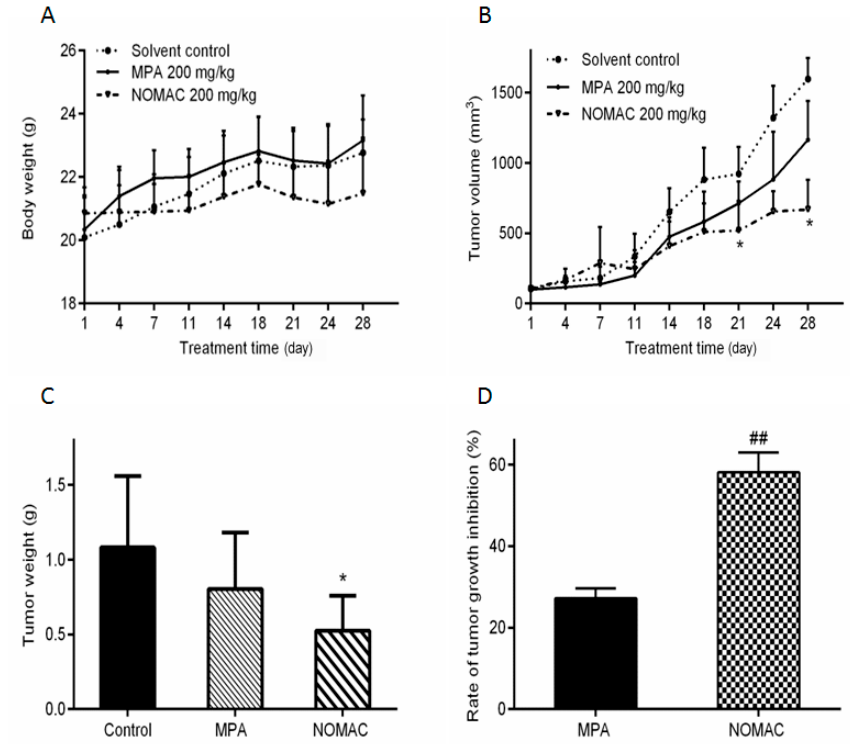
Figure 6. Effects of the same dose (200 mg/kg) of NOMAC and MPA on the growth of RL95-2 xenograft tumors in vivo ( n = 8). ( A ) Body weights of mice during the treatment of the tumor xenografts; ( B ) Changes in tumor volume during the treatment; ( C ) Tumor weights at the end of treatment; ( D ) Rate of tumor growth inhibition. Each point represents the mean ± SD ( n = 8). * p < 0.05 vs. control; ## p < 0.01 vs. the MPA group.